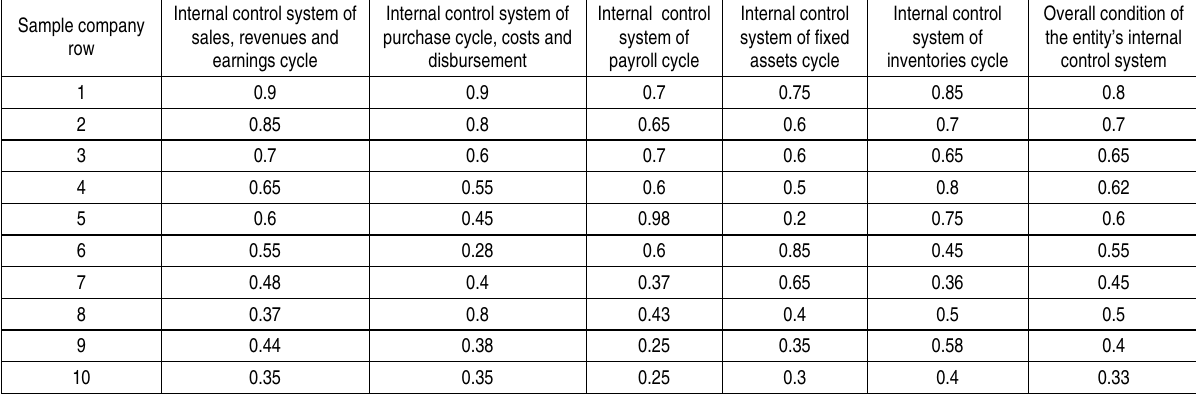
Table 6. The entity’s internal control system in 10 sample companies